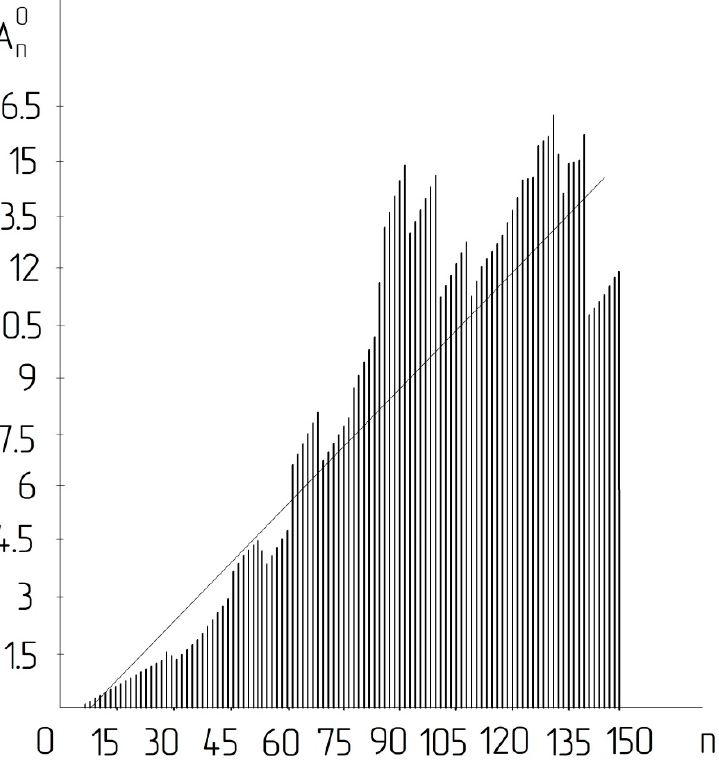
Figure 10. The spectrum of the rotor system is obtained by calculating the program.